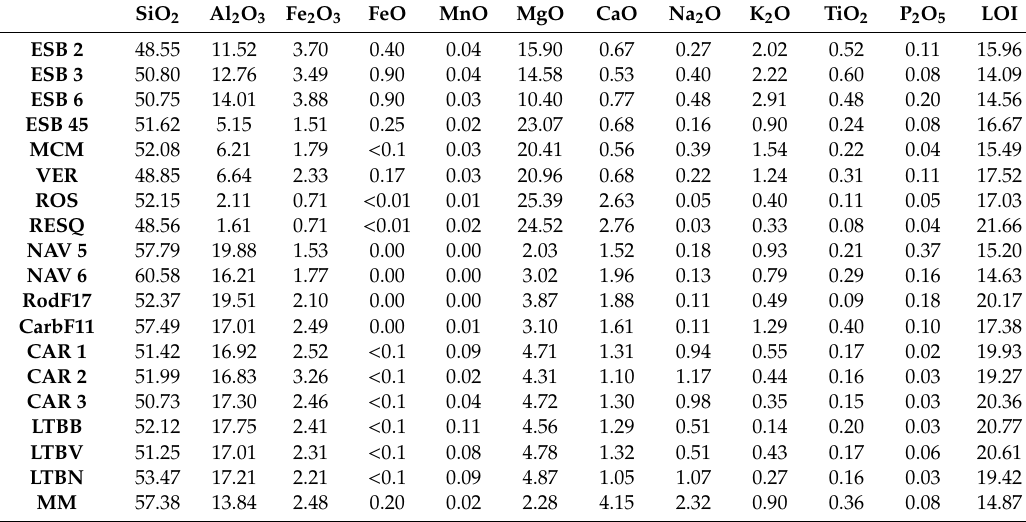
Table 2. Contents of major elements. Values in wt % oxides. LOI: loss of